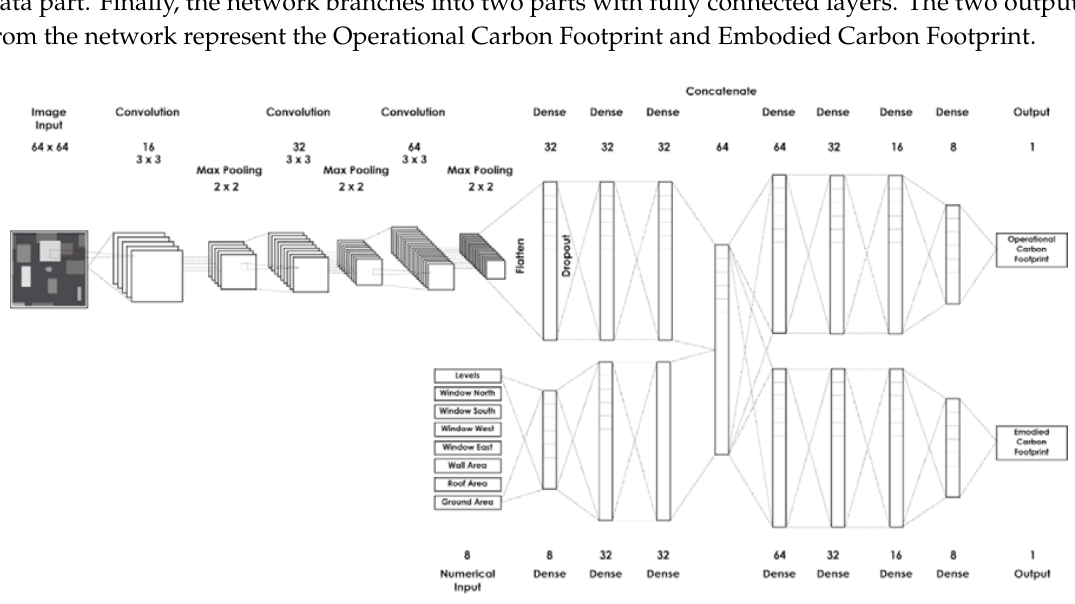
Figure 13. The network architecture combines graphical input analyzed by convolutional network and numerical input. Results of those partial neural networks are concatenated together. Then the network branches into two parts: One predicting the Operational Carbon Footprint and another predicting the Embodied Carbon Footprint of the